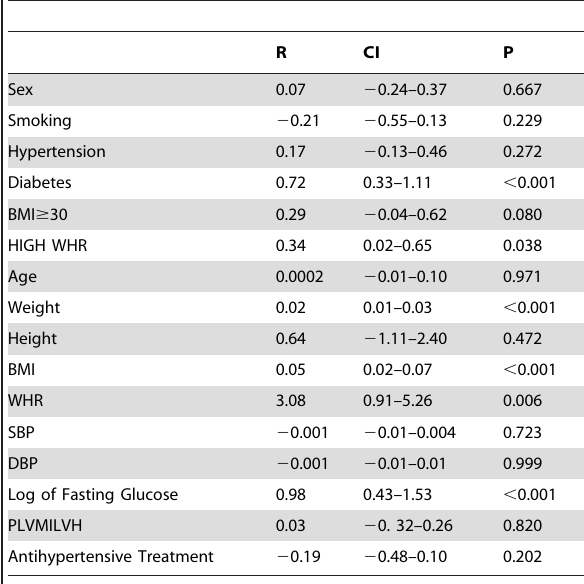
Table 6. Univariate analysis of variables with log of Insulin Resistance as the outcome variable.